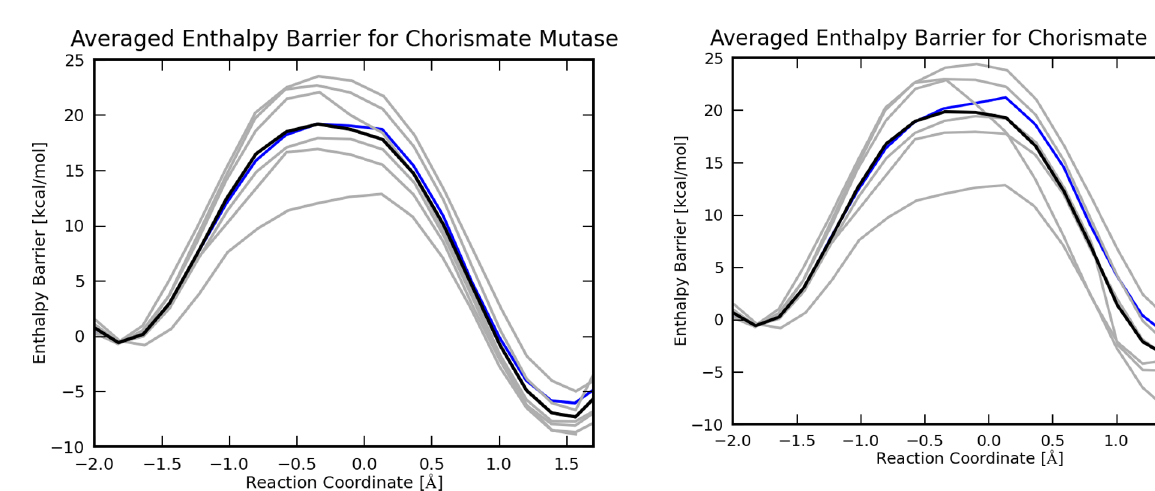
Figure 6. Reaction Enthalpy Profile for chorismate mutase. The 7 profiles are calculated with ONIOM at the MP2/cc-pVDZ:EFMO-RHF/6- 31G(d) level of theory. The black line is the average reaction energy, gray lines are individual reaction paths. The blue line is the reaction path discussed in detail, in the results section.